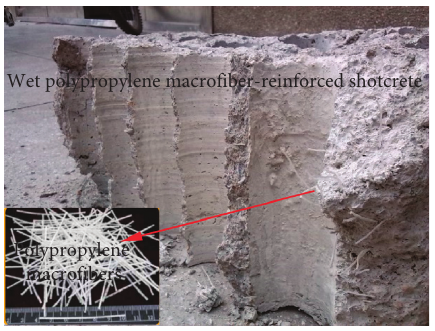
Figure 1: Appearance of polypropylene macrofibers and drilling of a wet shotcrete specimen. Table 2: Properties of polypropylene macrofibers.